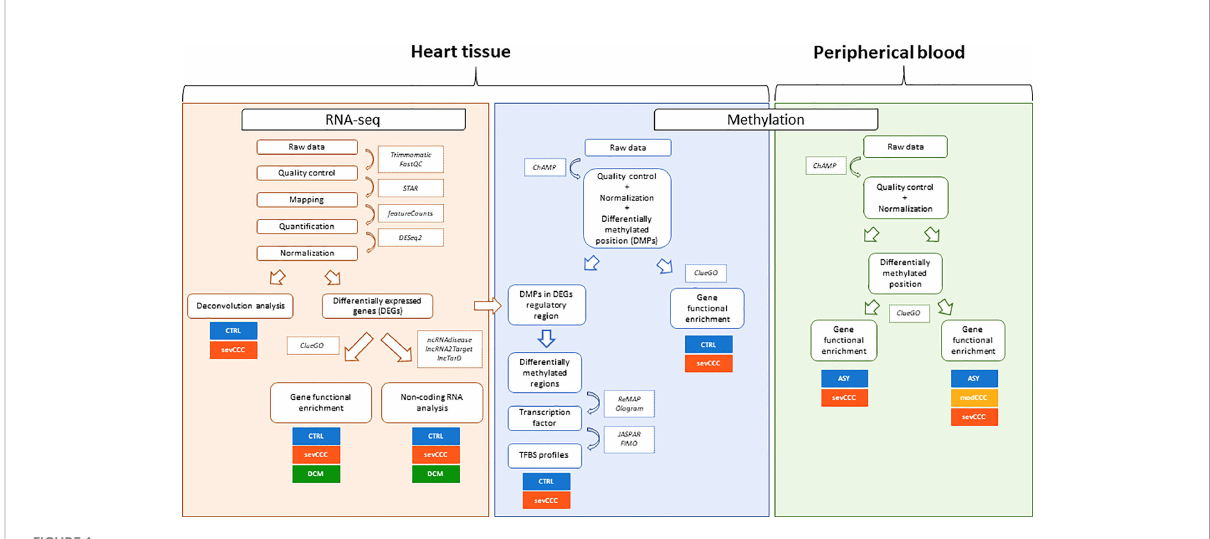
FIGURE 1 Work fl ow overview. Heart tissue RNAseq (orange) analysis was performed using classical steps: quality control, alignment, gene expression quanti fi cation and normalization. Then, three different analyses were done: deconvolution analysis, differentially expressed genes functional enrichment and non-coding RNAs characterization. Heart tissue (blue) and blood (green) methylation analysis followed the same fi rst steps: quality control, normalization, batch effect correction, differential methylation position (DMP) test and DMPs associated genes functional enrichment. In tissue samples, a transcription factor binding site (TFBS) enrichment was carried out on differentially methylated regions (DMRs).